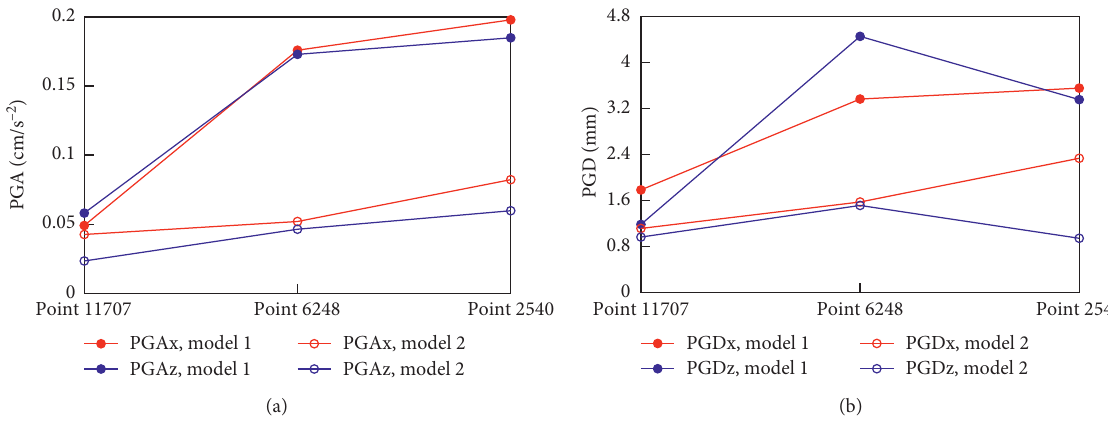
Figure 12: Changes of PGA and PGD of the slope under blasting loads. (a) PGA. (b)